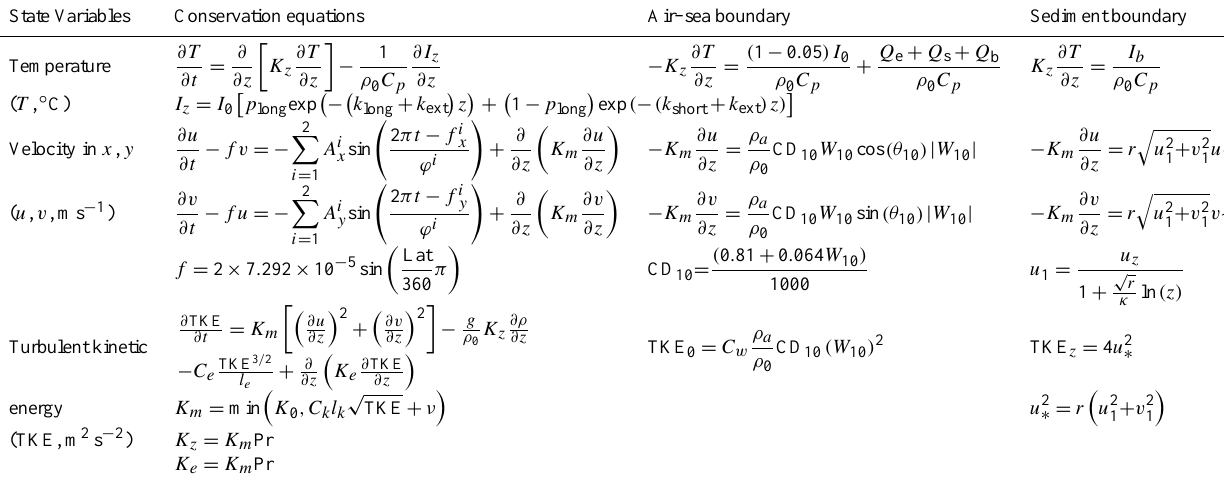
Table 1. Equations for the k - ε turbulence closure model. Table 2 lists the meaning of the state variables, output variables and forcing functions. The values of parameters are given in Table 3. The quantity z represents water depth.